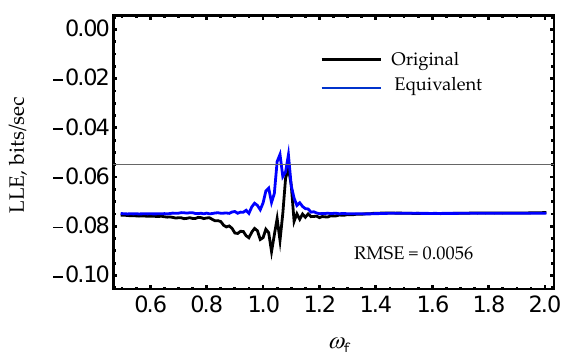
Figure 5. Largest Lyapunov Characteristic Exponent (LLE) curves computed from the numerical integration solutions of Equations (29) and (30). The parameter values used to obtain these plots were 𝑚 1 = 𝑚 2 = 1 , 𝑘 = 1 and 𝜀 = 0.5 with 𝑐 = 0.3 and 𝑓 1 = 0.25 . Here, the black, solid line represents the LLE computed from the numerical integration solutions of Equation (30), while the blue, dashed line describes the LLE obtained from Equation (29).